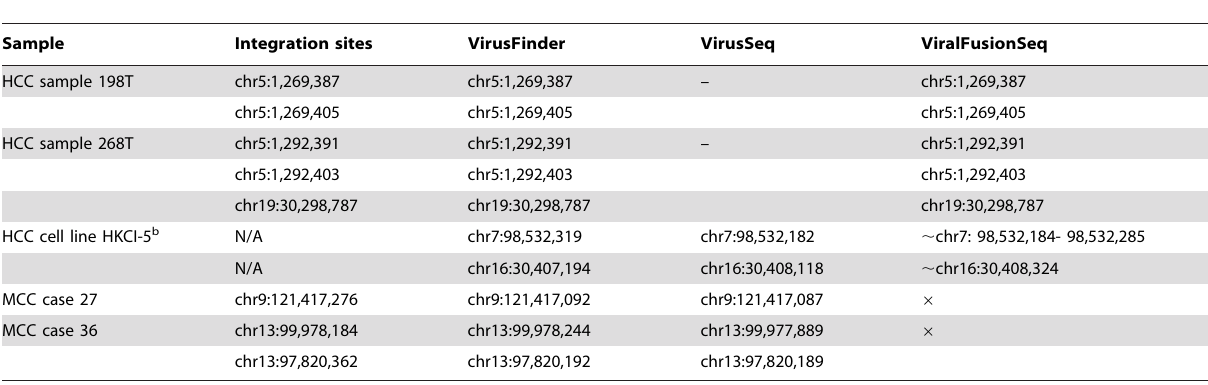
Table 2. Detection of virus integration sites in five NGS samples a